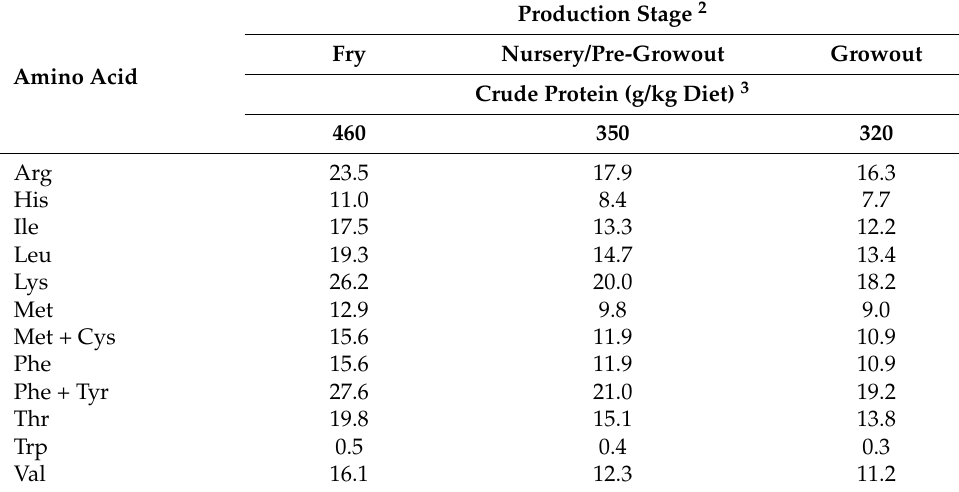
Table 3. Dietary amino acid recommendation (g/kg diet) for Nile tilapia 1 .